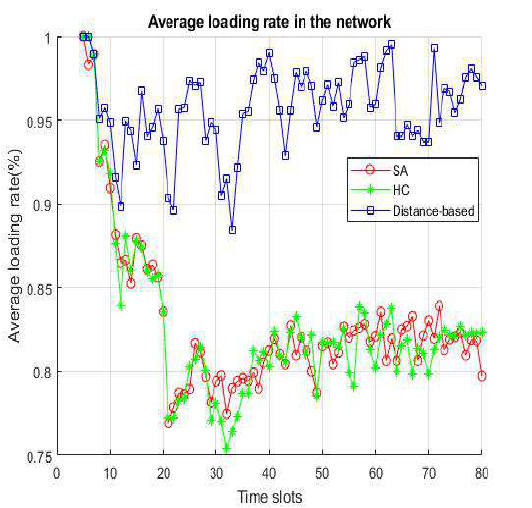
Figure 10. Average loading rate per time slot.